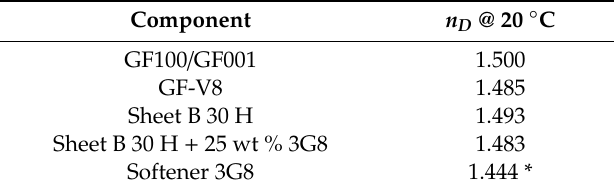
Table 4. Refractive index n at 589.3 nm ( n D ) as measured with Abbemat MW.